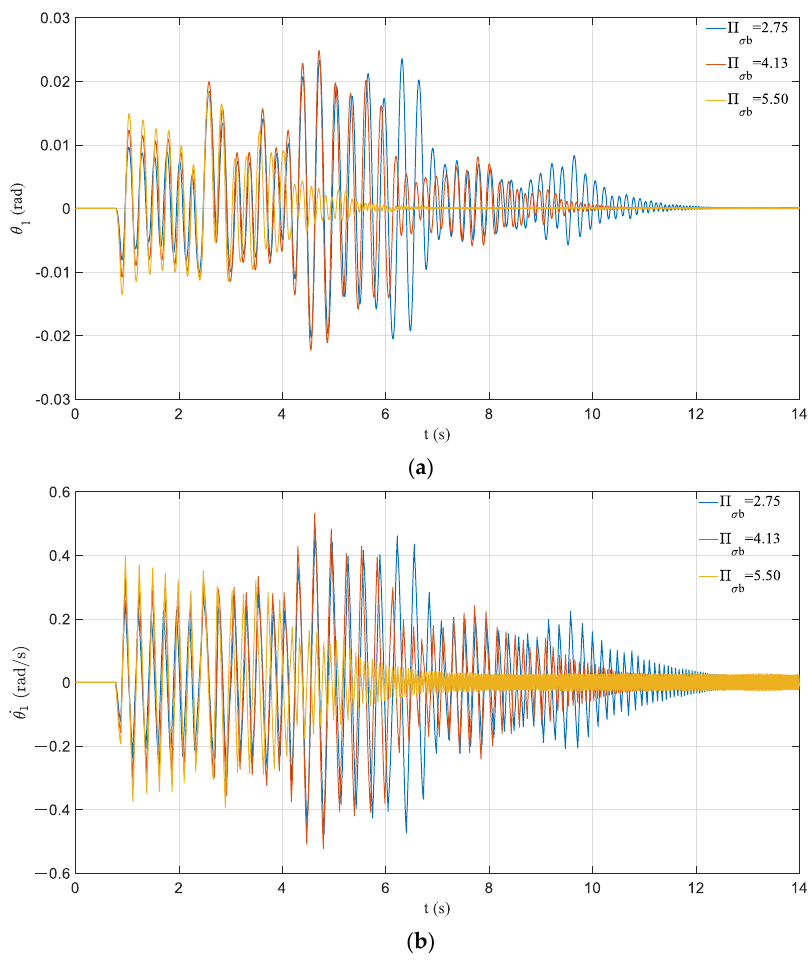
Figure 17. Effect of variation in Π σ b : ( a ) time history of rocking rotation; ( b ) time history of angular velocity.